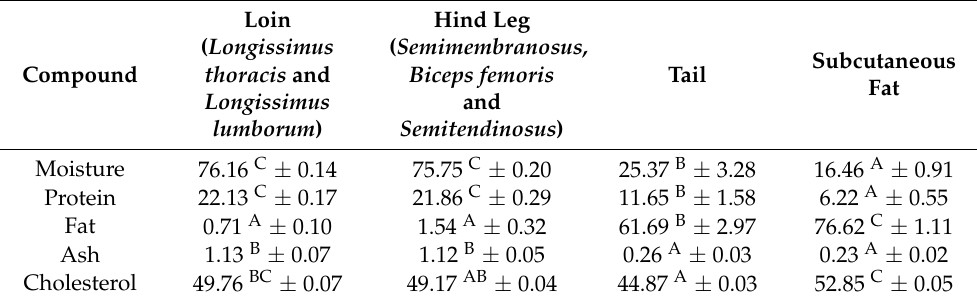
Table 1. Proximate composition (%) and cholesterol content (mg/100 g) of beaver tissues (mean and standard error).